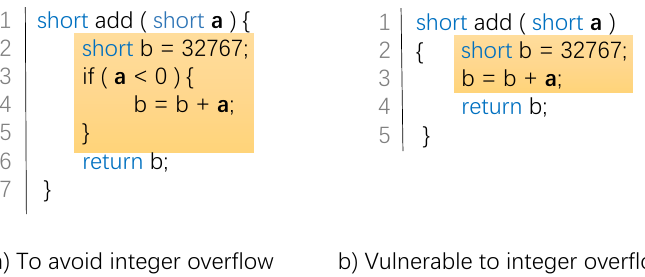
Figure 1. Toy examples [3] of ( b ) an integer overflow and ( a ) one way to avoid